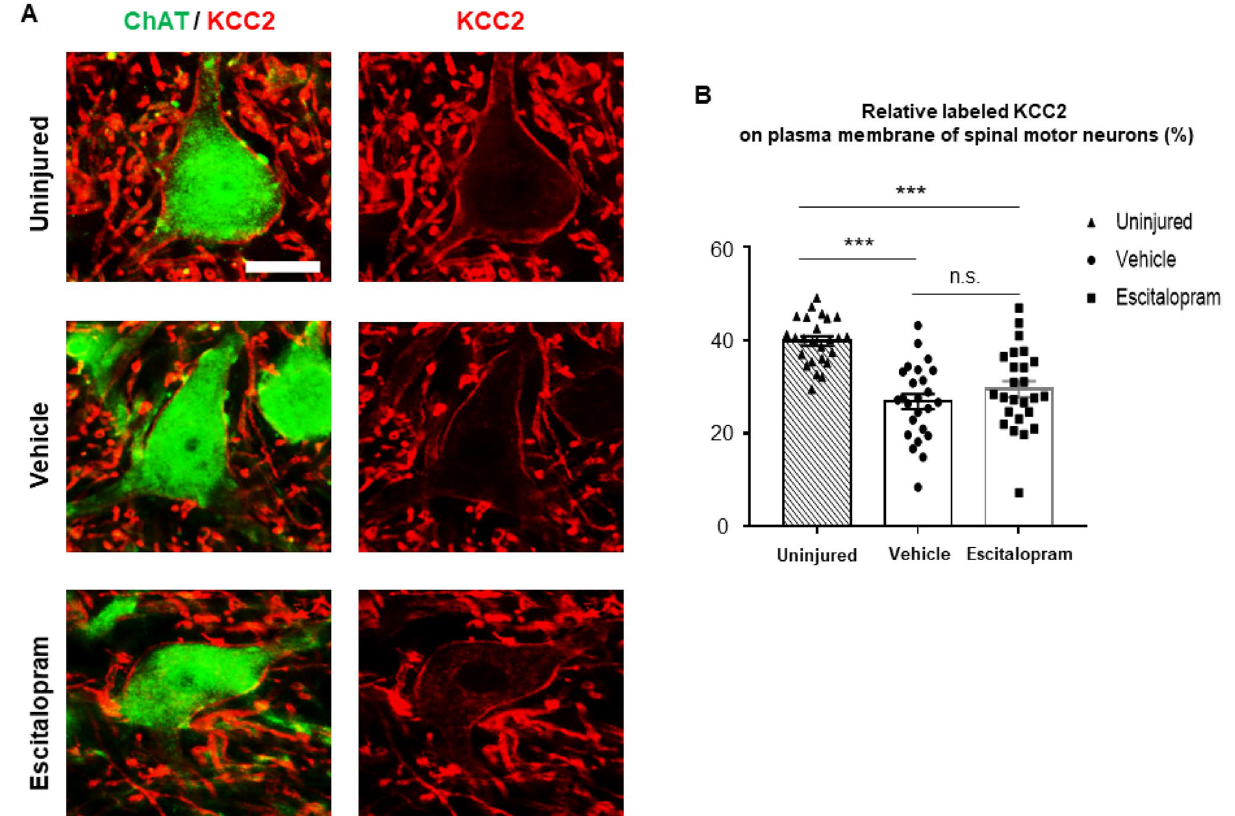
Figure 5. Plasma membrane labeled KCC2 immunostaining on the lumber spinal motor neurons. ( A ) Representative microscopic images of anti-KCC2 immunostaining (red) on the ChAT positive-lumbar motor neurons (green) of each group are presented. Scale bar: 25 μm. ( B ) Quantitative analysis of plasma membrane labeled KCC2 of each group, normalized to uninjured and shown as a bar graph (dashed bar with triangular plots: uninjured group, grey bar with round plots: vehicle-treated group, white bar with rectangular: escitalopram-treated group). *** P < 0.001, n.s. non-significant.